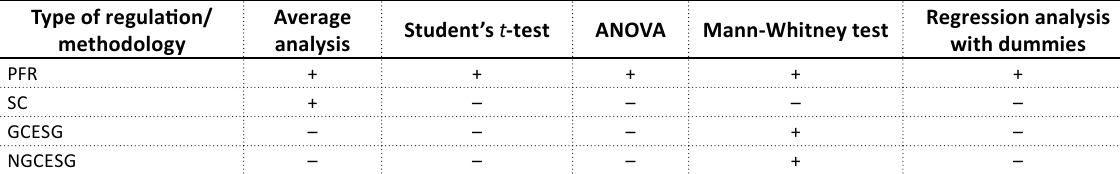
Table 2. Overview of the results for ESG criteria Type of regulation/ methodology